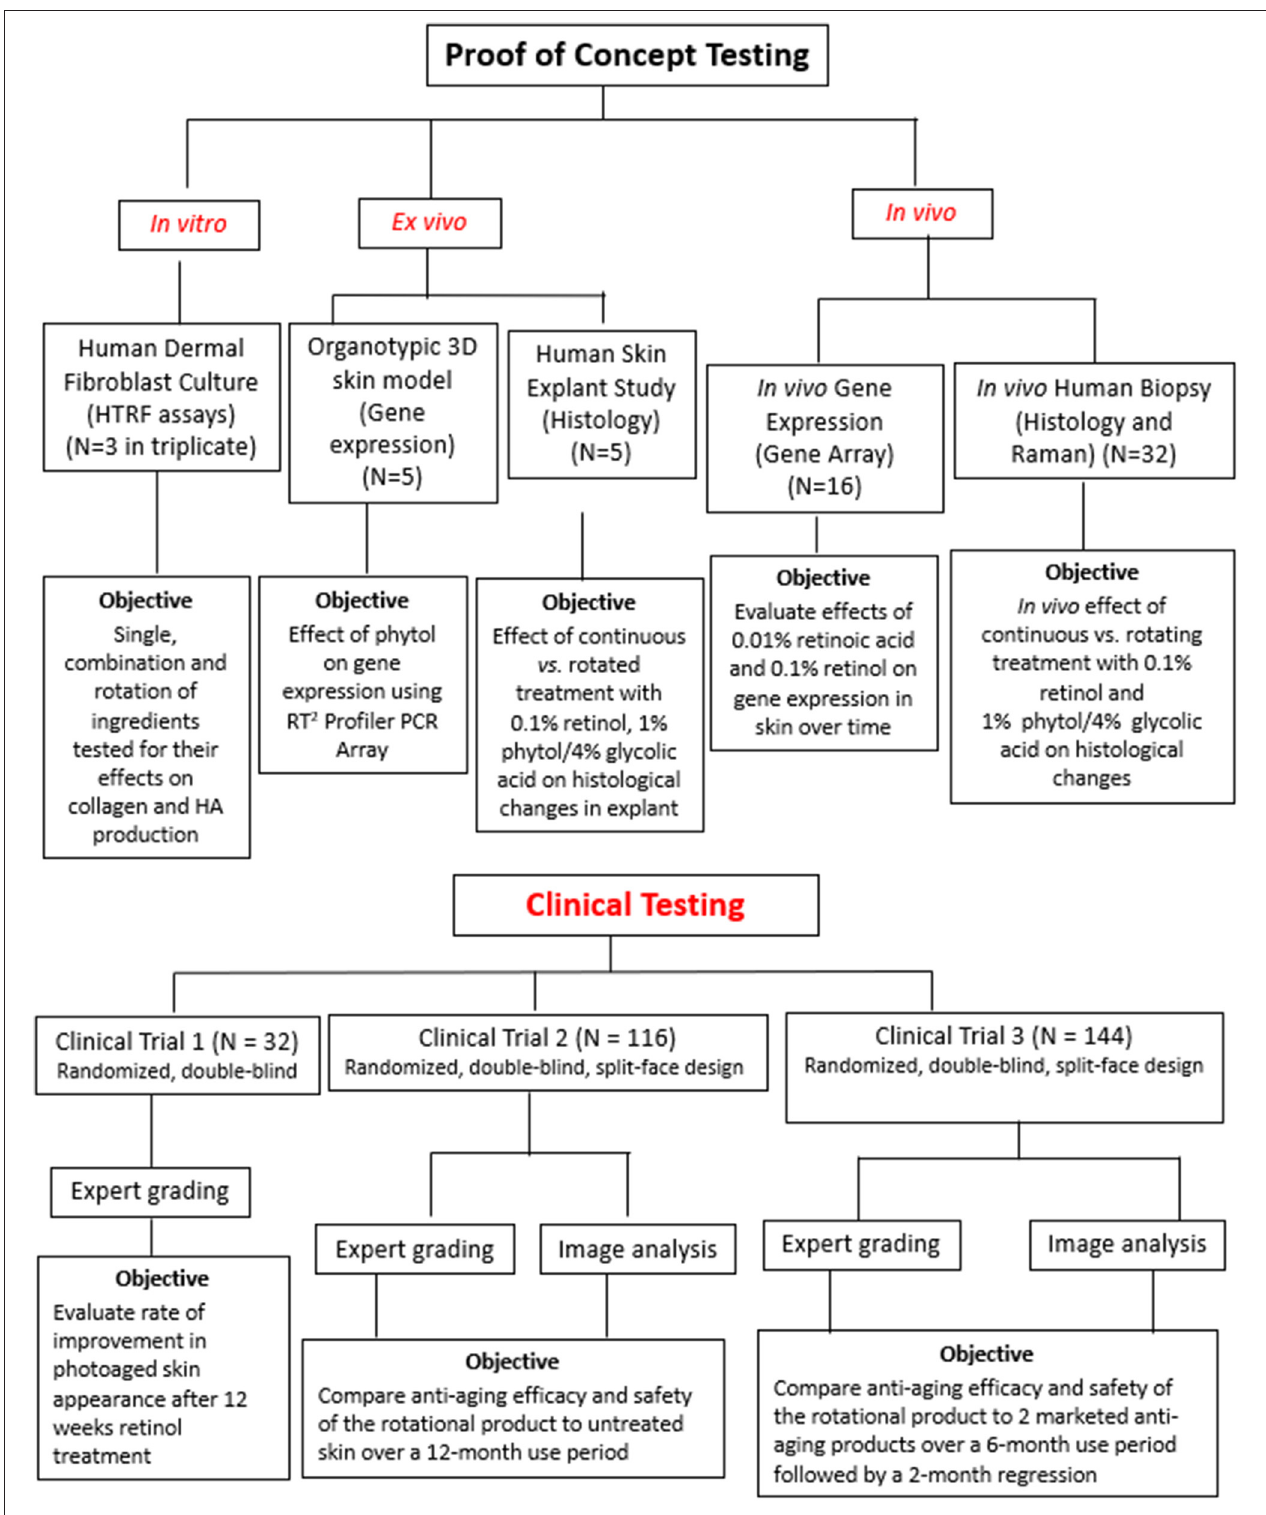
FIGURE 2 | Study methodological flowchart. This flowchart represents the summary of laboratory and clinical testing conducted with the novel rotational regimen.